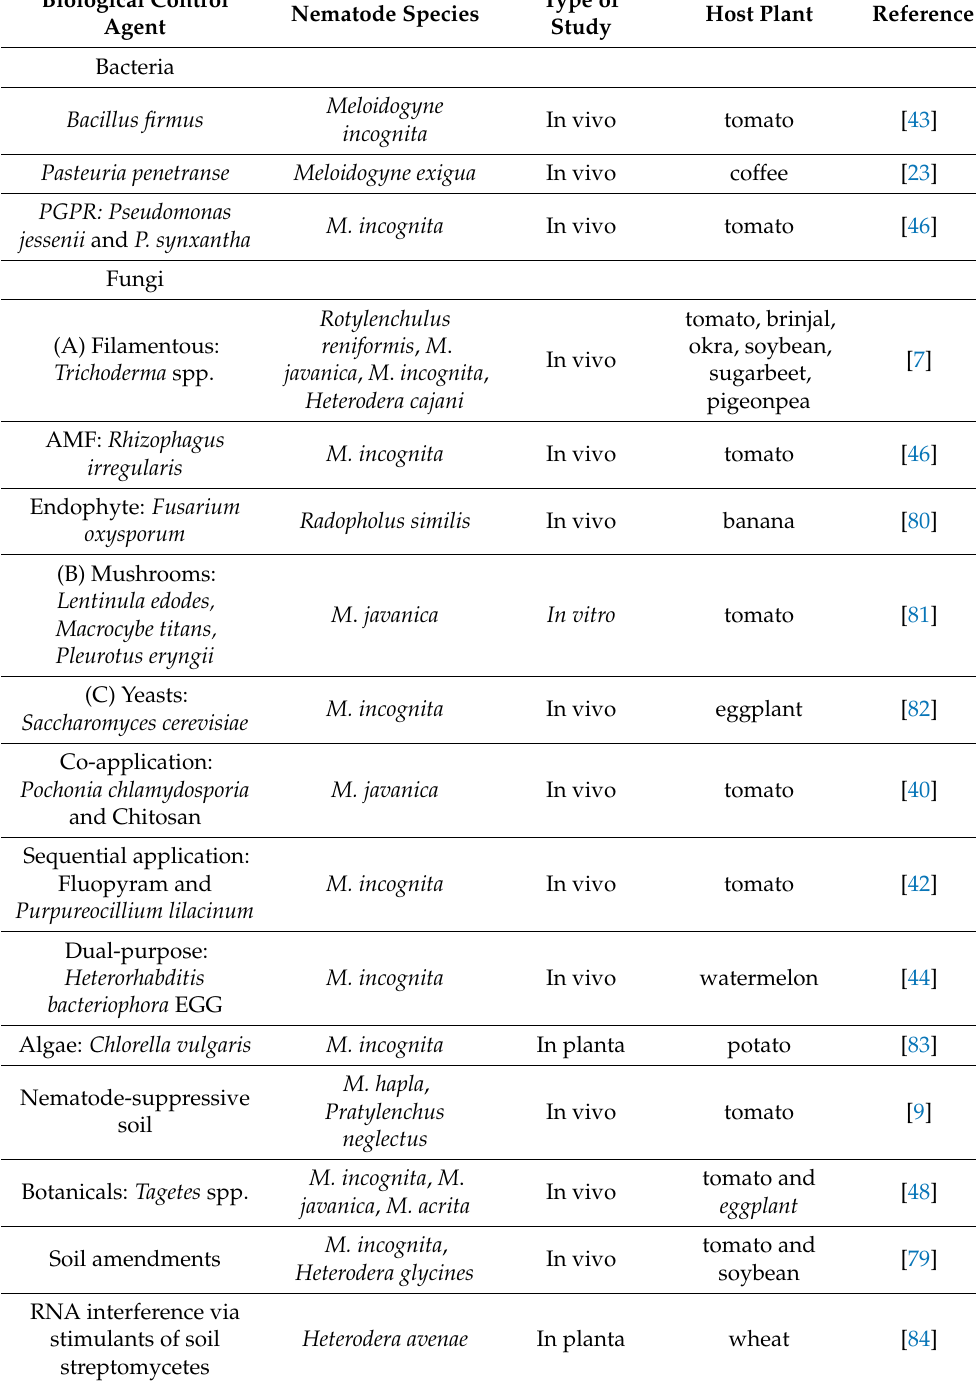
Table 1. Examples of various biocontrol agents and strategies against important nematode